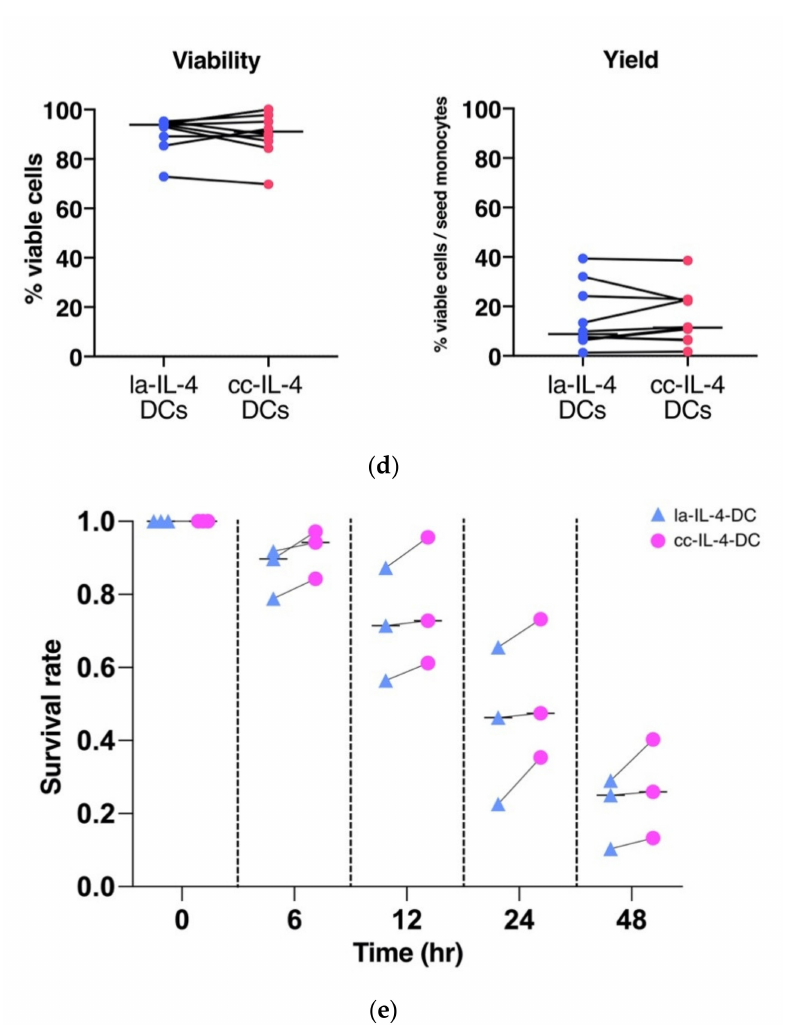
Figure 2. Cluster − controlled IL-4 − DC preparation. ( a ) low − adherent − IL-4 − DCs (la − IL-4 − DCs) and cluster − controlled IL-4 − DCs (cc − IL-4 − DCs) were generated from monocytes that were purified from PBMCs as described in Section 2.2. ( b ) Image of cells observed by phase − contrast microscopy before harvesting by washing with media. The yellow bar indicates 1000 µ m. ( c ) A box plot shows the semiquantitative analysis of the cell area. The total cell cluster area was calculated using Image J software by averaging areas in each experiment ( n = 3). Quantification of cell area from microscopic images is represented as the minimum and maximum areas ( n = 3). The thickness of cluster size at the DC maturation phase. Z − stacking analysis with XZ and YZ orthogonal views on cell cluster in la − IL-4 − DCs and cc − IL-4 − DCs. The yellow bar indicates 100 µ m. ( d ) Live and dead cells were measured before cryopreserved by trypan blue staining to compare viability and yield of the DC/monocyte ratio ( n = 10). The horizontal bars in graphs show the median of each parameter. ( e ) The analysis of cell survival in la − IL-4 − DCs and cc − IL-4 − DCs as described in Section 2.4 ( n = 3). The horizontal bars in graphs represent the median of each